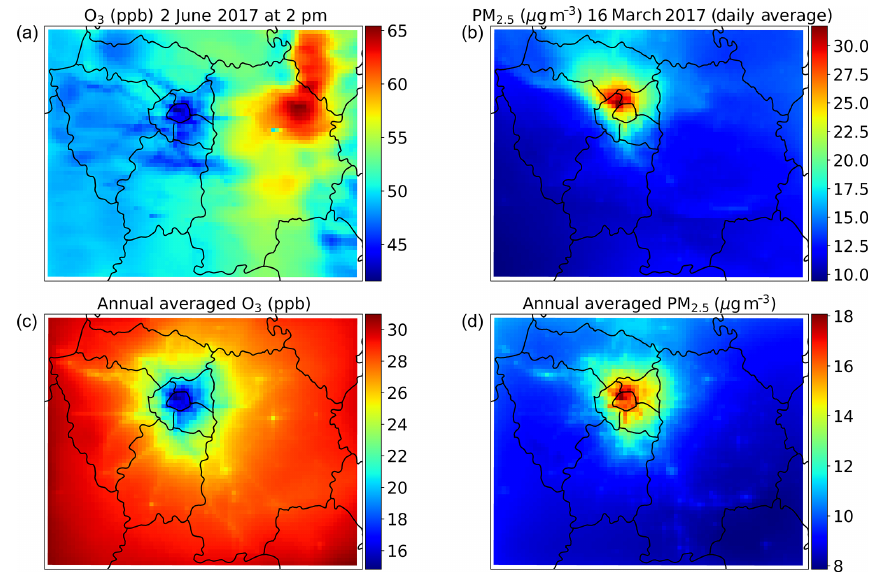
Figure 3. Surface O 3 (a, c) and PM 2 . 5 (b, d) concentrations modelled with the CHIMERE chemistry–transport model. Maps on top show example of hourly averaged O 3 concentration (a, c) and daily averaged PM 2 . 5 concentration (b, d) for a specific hour/date. Maps on the bottom are annual averaged